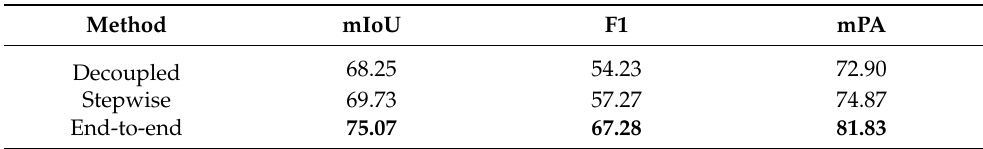
Table 3. Comparison of different RUF joint training approaches on validation set. Best results are in bold.